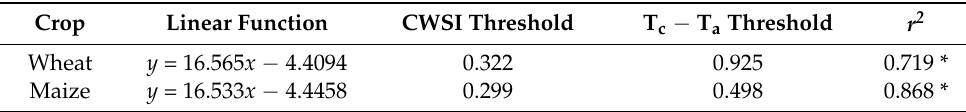
Table 3. Using correlation between T c − T a ( y , ◦ C) and CWSI ( x ) to determine the T c − T a threshold ( ◦ C) for winter wheat and summer